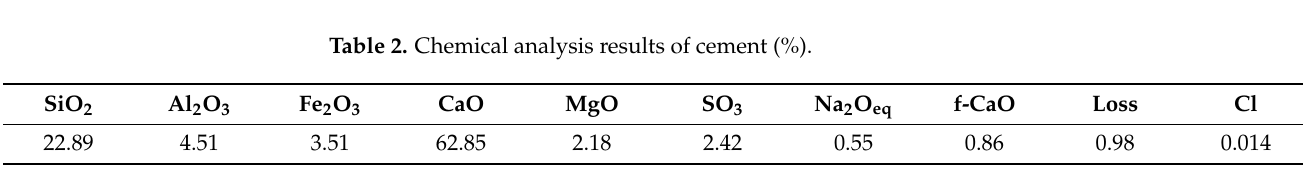
Table 3. Physical properties of